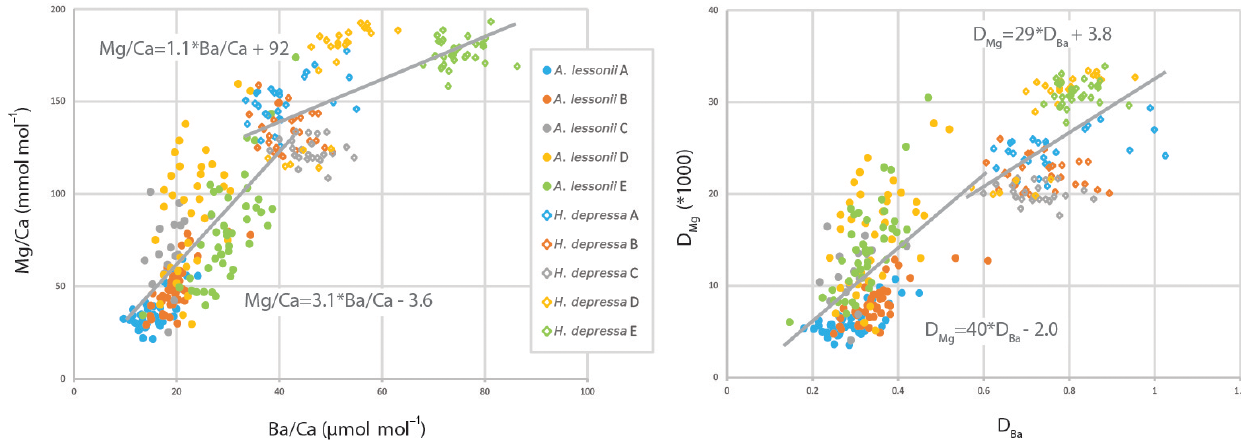
Figure 4. Relation between the Ba / Ca and Mg / Ca (left panel) and the partition coefficients for Ba and Mg (right panel). Every dot represents one single-chamber measurement. The data for A. lessonii are indicated by circles; those for H. depressa are represented by open diamonds. Every treatment (A–E, Table 1) is indicated by a separate